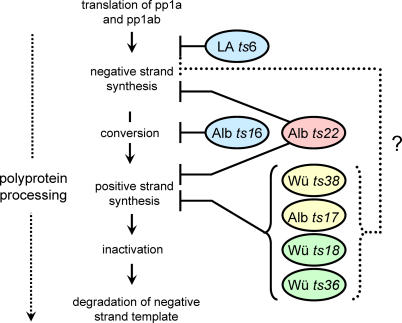
A Model to Describe the Pathway for Viral RNA Synthesis in MHV-A59-Infected CellsShows a working model that describes a pathway for viral RNA synthesis in MHV-A59-infected cells. The model proposes that the replicase-transcriptase complex forms initially and creates a negative-strand template. It is then converted to utilize the negative strand as a template for positive-strand synthesis and, finally, the complex is inactivated by the degradation of negative-strand templates. It is also proposed that proteolytic processing of the replicase polyproteins plays a role in regulation of this pathway. Also depicted are the putative defects of specific MHV-A59 ts mutants. It remains to be shown whether or not the group IV and VI mutants (Wü ts38, Alb ts17, Wü ts18, and Wü ts36) are defective in negative-strand RNA synthesis at the non-permissive temperature.